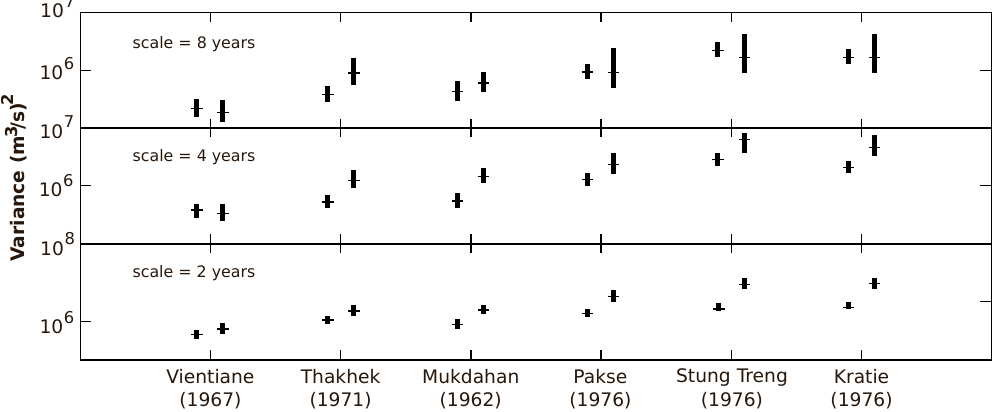
Fig. 3. Discrete wavelet variance estimated for the stations depicted in Fig. 1. Step changes in variance were detected with a statistic based on the cumulative squared variance. The variance of the signal before and after the change is shown with confidence intervals. In the southernmost stations, this change occured in 1976. The changes are significant for confidence intervals that do not intersect.